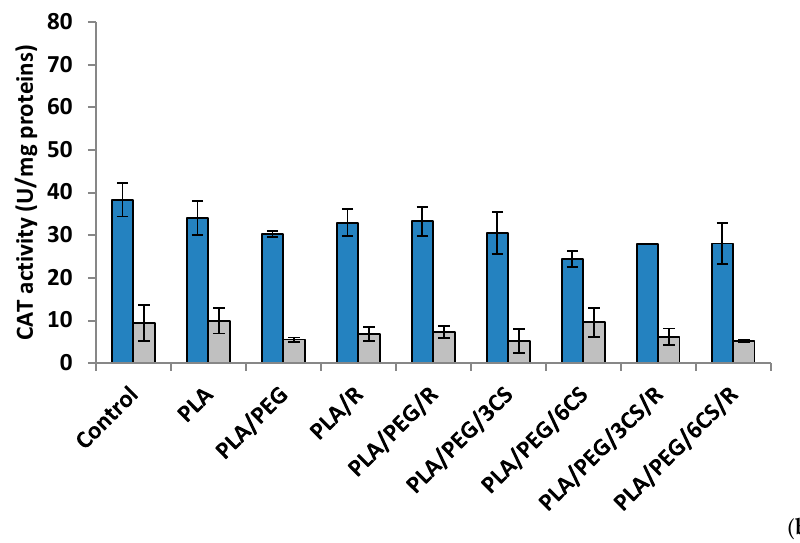
Figure 5. Catalase (CAT) activity in P. chrysosporium (dark blue columns) and C. globosum (grey columns) after 7 days ( a ) and 14 days ( b ) of incubation in the presence of PLA-based samples. Another parameter of oxidative damage evidenced in the mycelium of both fungi was measured as malondialdehyde content (MDA) (Figure 6a,b).